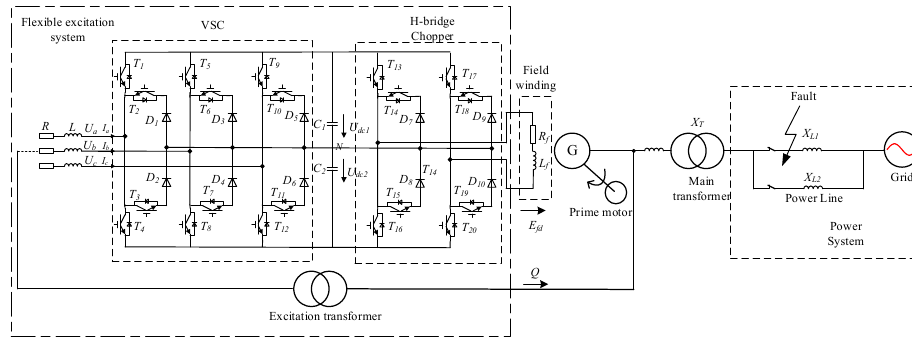
Figure 7. Structure of simulation platform.